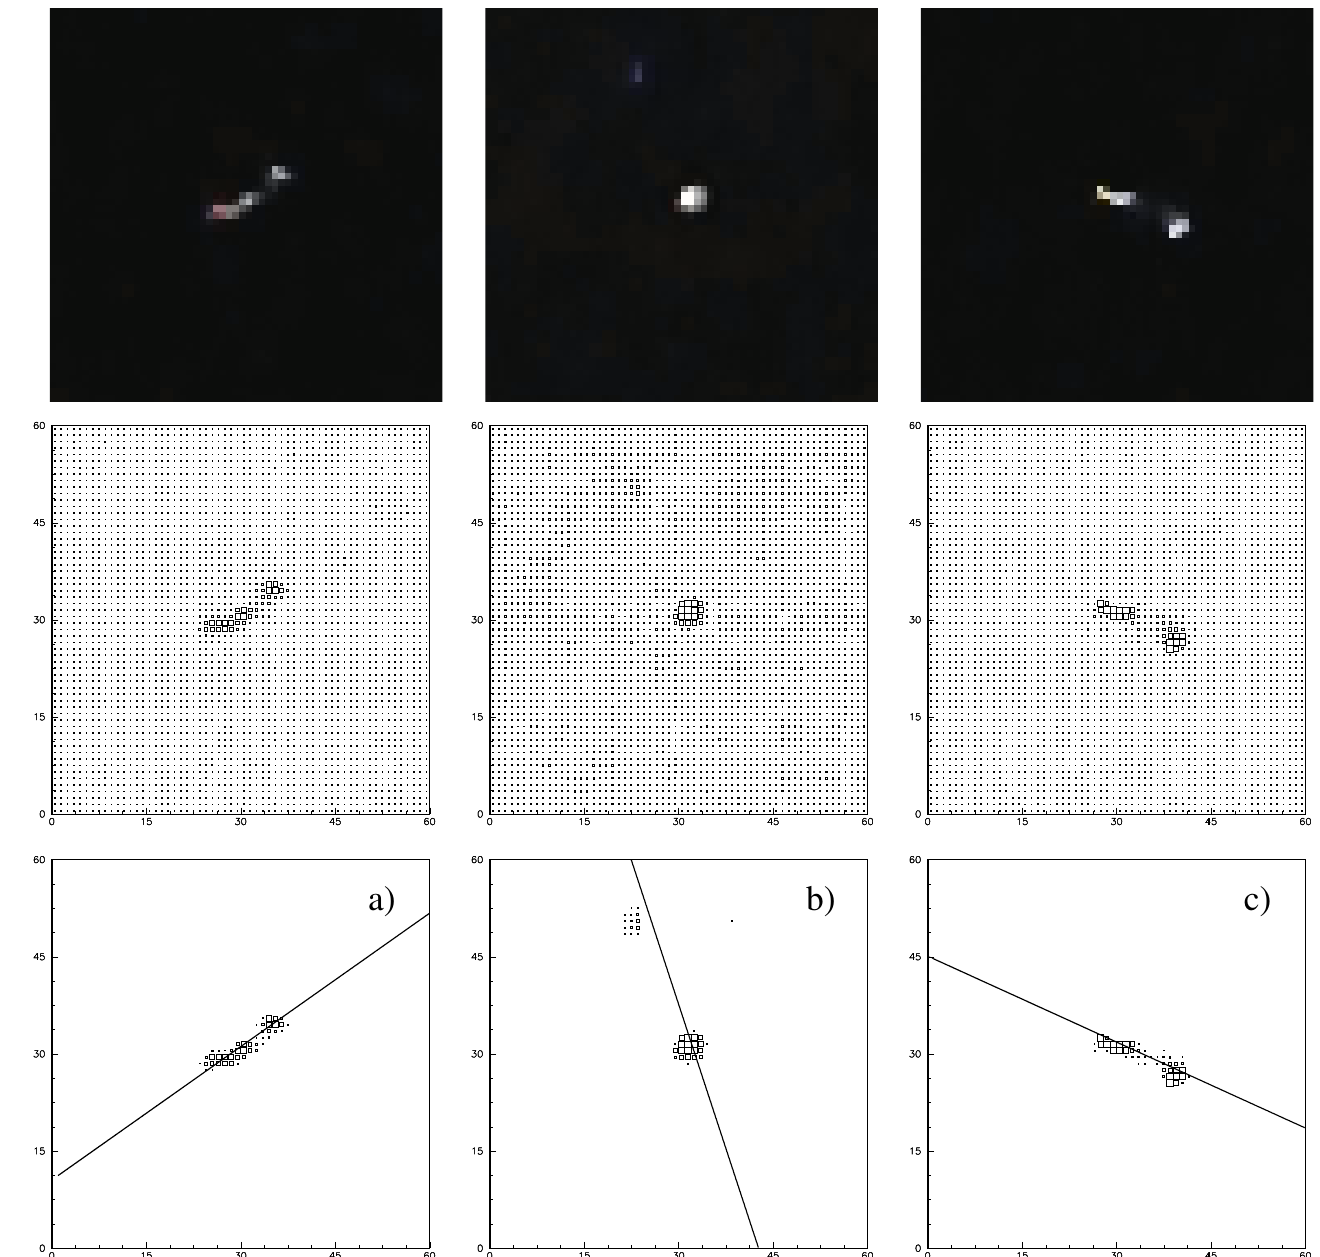
Figure 1. Three example pictures ( a – c ) of traces from the CREDO database. The top row shows the original smartphones images, the middle row shows the same events with the size of boxes proportional to the pixel signal (registered light). The bottom row presents the estimated main axis of the “muon